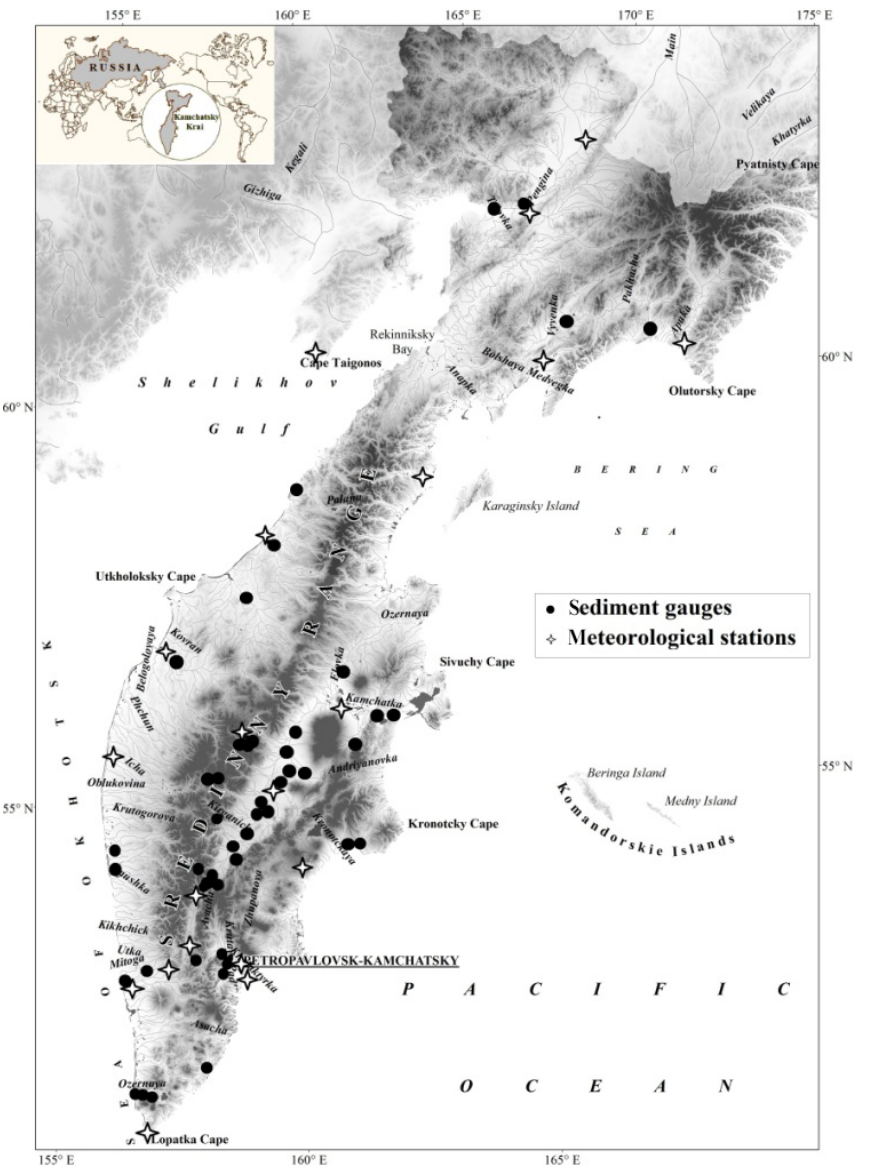
Figure 1. Distribution of suspended sediment yield and meteorological monitoring stations in the Kamchatsky Krai. Rivers: (1) Paren’, (2) Pakhacha, (3) Penzhina, (4) Avacha, (5) Talovka, (6) Tigil’, (7) Udova, (8) Asacha, (9) Bol’shaya Vorovskaya, (10) Bol’shaya (Bystraya), (11) Bryumka, (12) Phchyn, (13) Voyampolka, (14) Vyvenka, (15) Zhupanova, (16) Icha, (17) Kamchatka, (18) Kronotckaya, (19) Oblukovina, (20) Ozernaya, (21) Ozernaya, (22) Palana, (23) Khairyuzova.